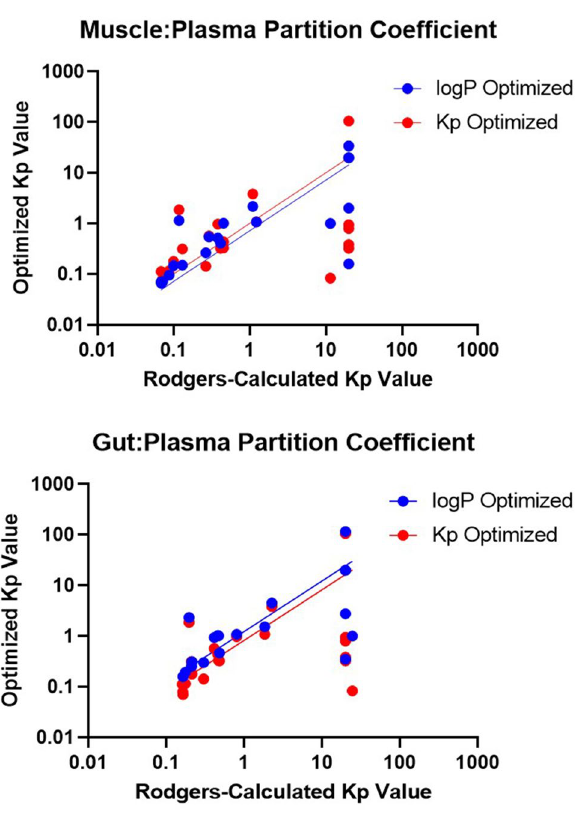
Figure 6. Comparison of the simulated Kp values to the Rodgers-calculated values for gut and muscle compartments with linear regression